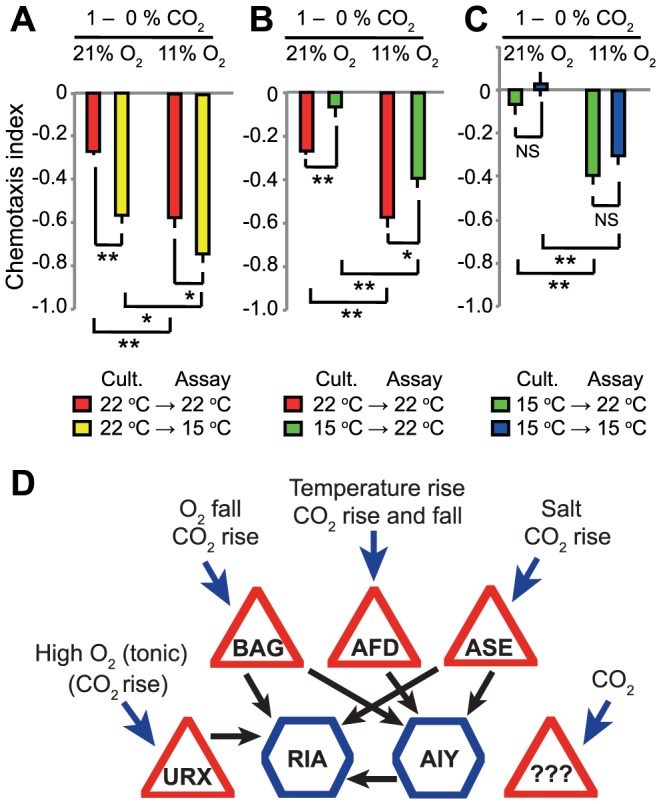
Acclimation temperature and ambient O2 levels have additive effects on CO2 avoidance.A. Animals cultivated at 22°C but assayed at 15°C avoid CO2 more strongly when ambient O2 is low. B–C. Reducing O2 levels from 21% to 11% increases CO2 avoidance regardless of acclimation temperature or assay temperature. In A–C, ** p<0.01, * p<0.05, ns, not significant, Student's t test. D. Coalitions of CO2 sensors elicit CO2 escape responses according to O2 environment, temperature experience, and CO2 stimulus dynamics. Triangles represent sensory neurons and hexagons interneurons. Black arrows indicate synapses. Several neurons respond to CO2 (blue arrows), each with distinct kinetics. Each of these neurons also responds to other sensory cues, as indicated. Three of the four identified CO2 sensors synapse directly onto the RIA interneuron. The fourth, AFD, synapses onto AIY which in turn synapses on RIA. The URX O2 sensor also synapses onto RIA. Note each neuron makes additional connections besides the ones highlighted here.